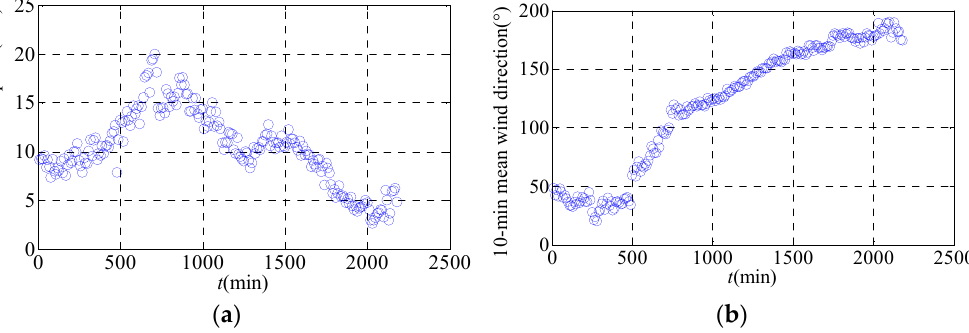
7 of 19 Figure 5. Diagram of horizontal wind speed decomposition.